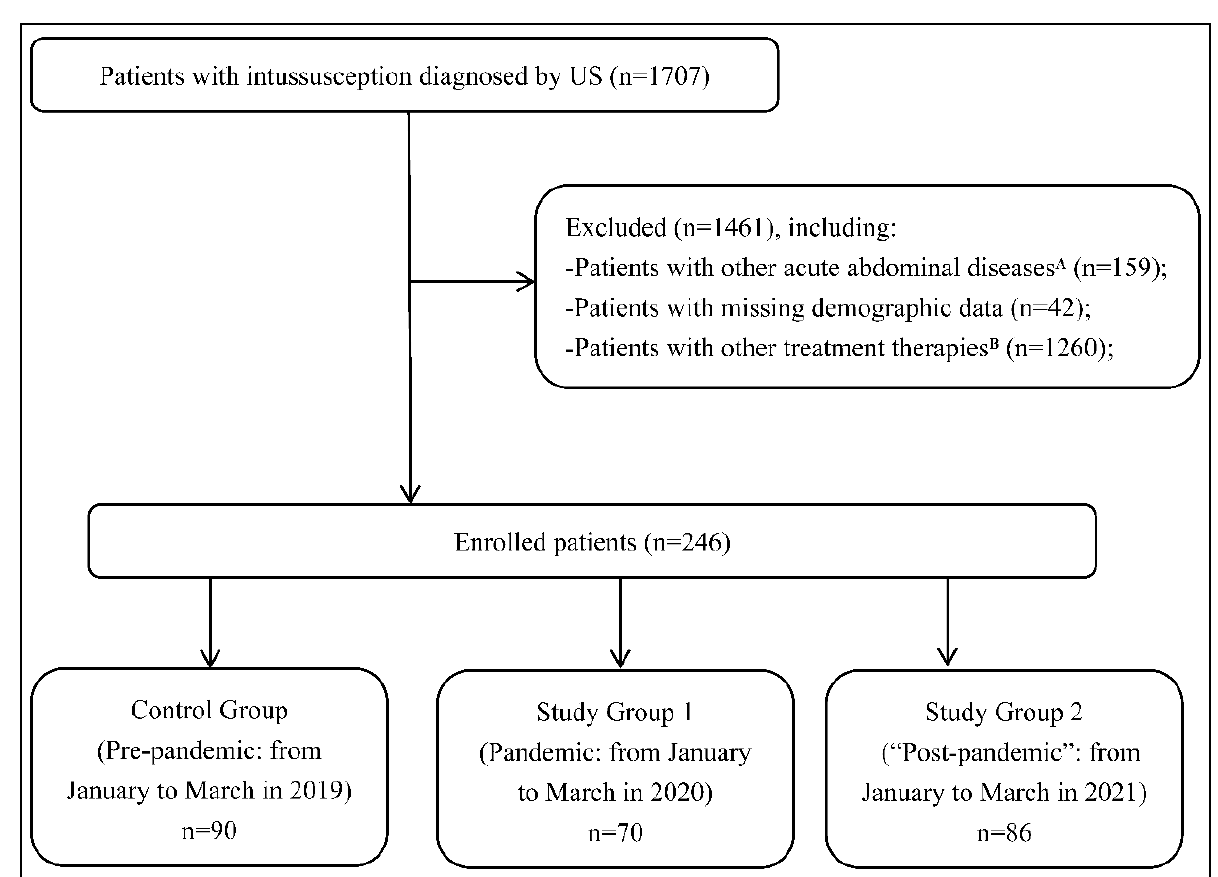
Figure 1. Flow chart of the present study. There were 1707 patients who were diagnosed with intussusception using US. We excluded 1461 patients who did not meet the inclusive criteria and ultimately enrolled 246 ones in this study. There were 90 patients in Control Group (pre-pandemic), 70 patients in Study Group 1 (pandemic), and 86 patients in Study Group 2 (“post-pandemic”). A : Refers to patients with intussusception combined with other acute abdominal diseases, such as appendicitis, pancreatitis, and intestinal obstruction of unknown origin. B : Refers to patients with intussusception receiving X-ray-guided pneumatic enema reduction, direct surgical treatment, and other non-invasive therapies. Note: US =